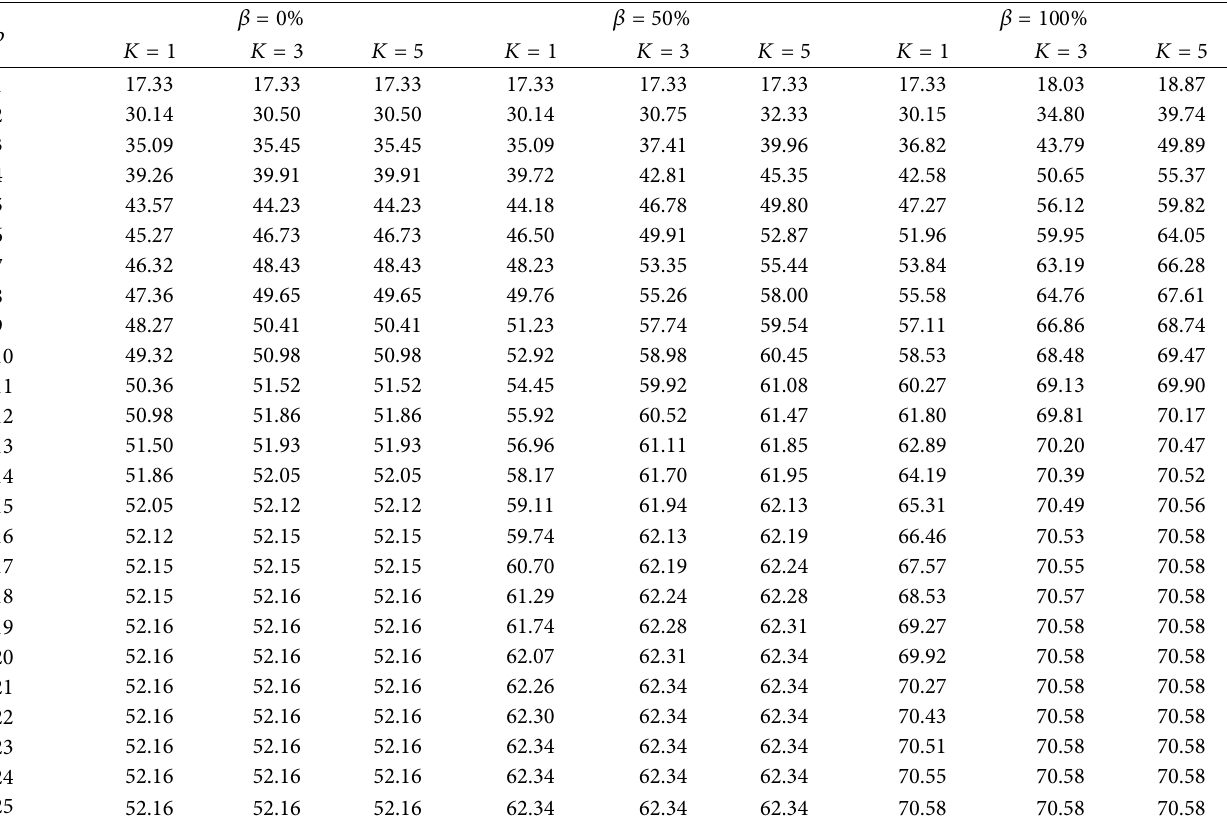
% , % , and % when . 훽 = 0 훽 = 50 훽 = 100 푅 = 20